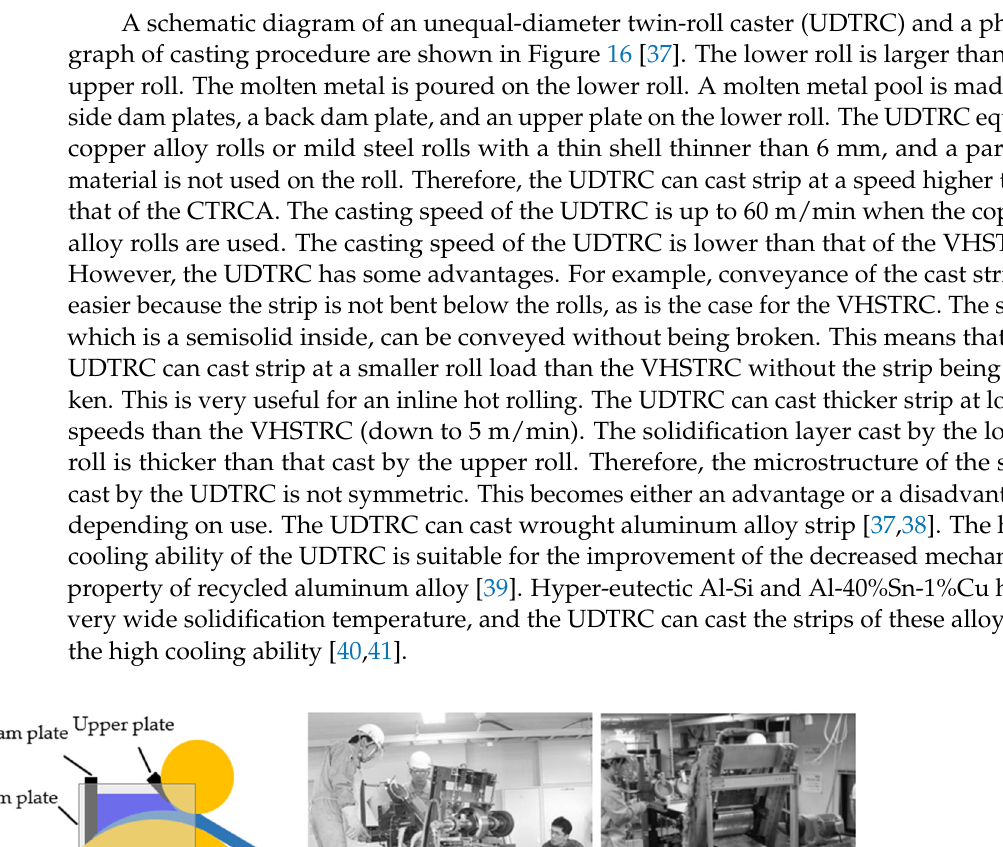
Figure 15. Coil of Al-20vol%SiC p 100-mm-width strip and microstructure of Al-30vol%SiC p strip. Roll speed: 60 m/min, Roll diameter: 300 mm, Roll width: 100 mm, Solidification length: 100 mm, Roll load: 0.27 kN/mm.